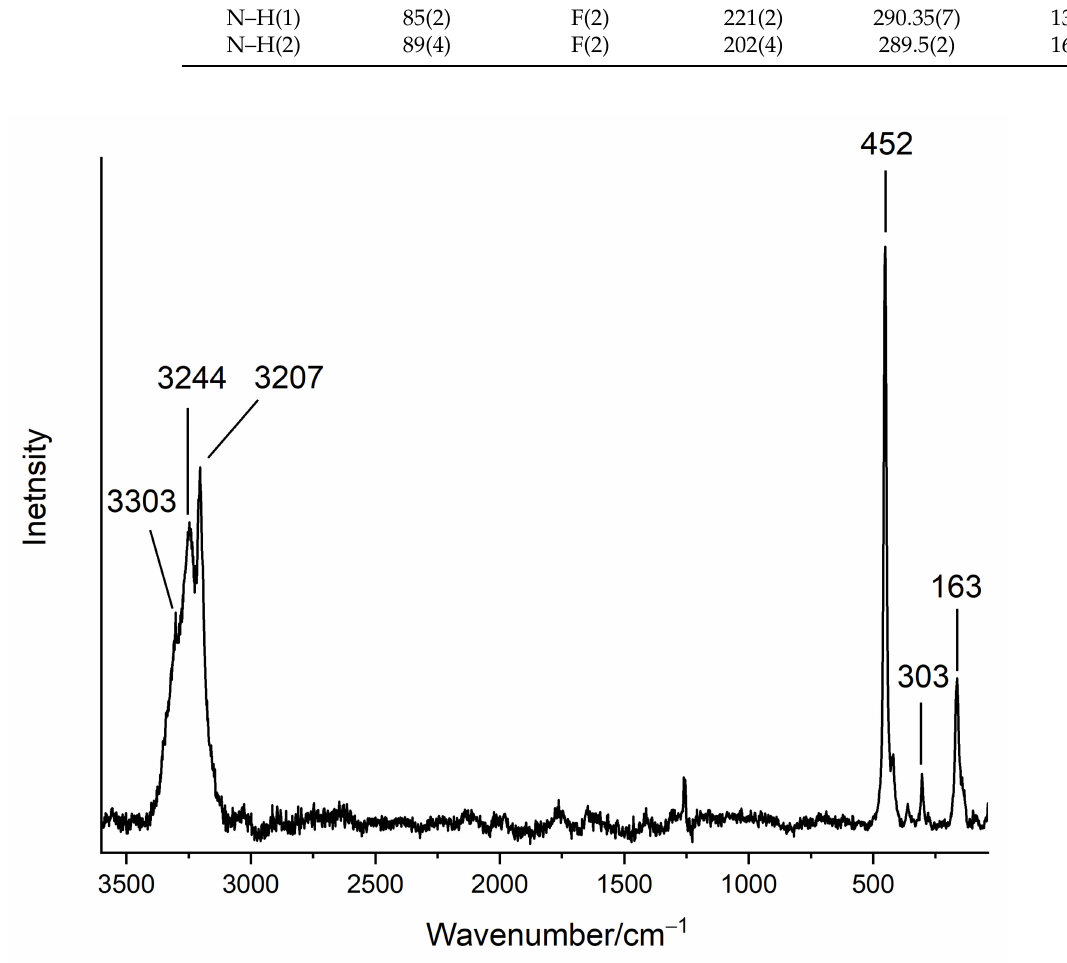
Figure 4. Single crystal Raman spectrum taken on InAlF 6 (NH 3 ) 2 , excitation wavelength: 532